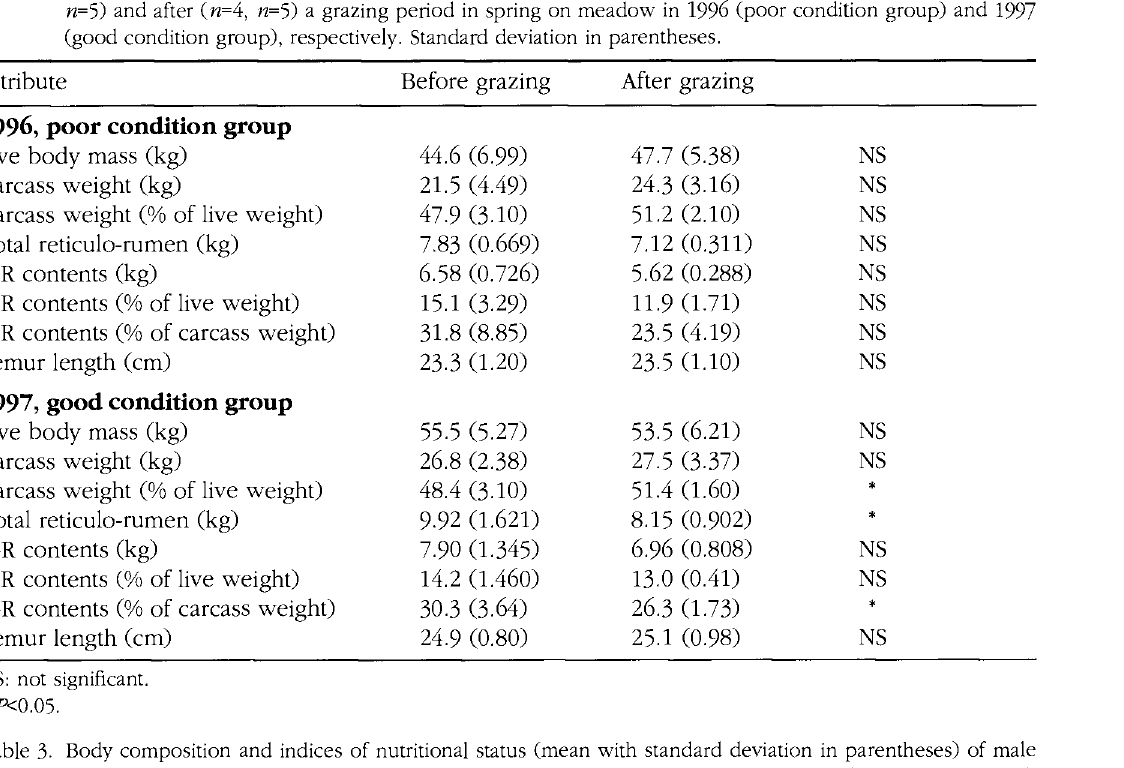
Table 3. Body composition and indices of nutritional status (mean with standard deviation in parentheses) of male reindeer yearlings slaughtered before («=3, n=5) and after (w=4, «=5) a grazing period in spring on mead ow in 1996 (poor condition group) and 1997 (good condition group),